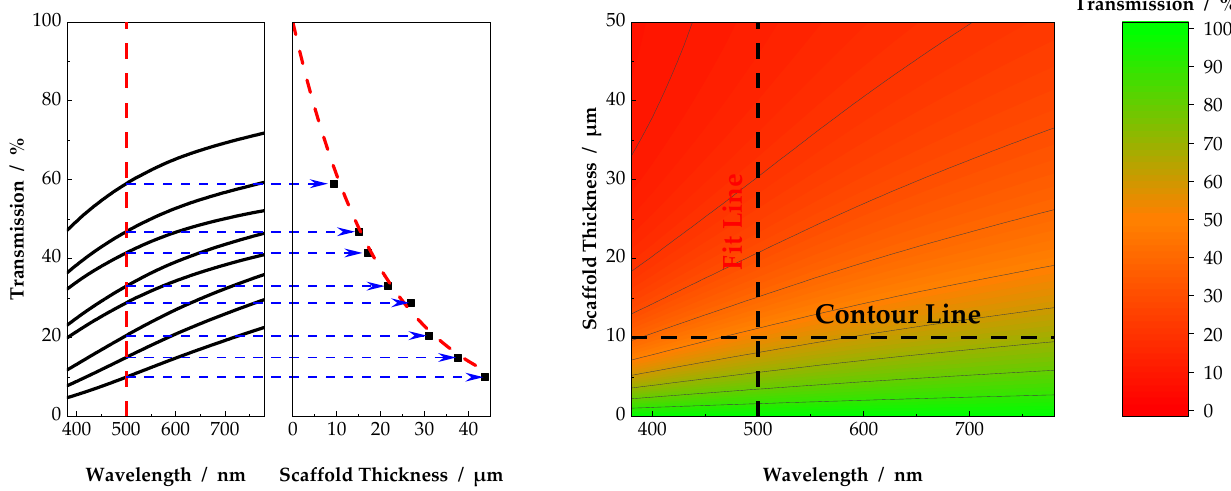
Figure 3. From the individual transmission values, transmission-versus-scaffold thickness plots were generated for discrete wavelengths. Using the fit lines, contour plots were generated for individual scaffolds and enclosing media. Using the contour lines, a comparison between different scaffolds and environmental parameters at various scaffold thicknesses could be made.